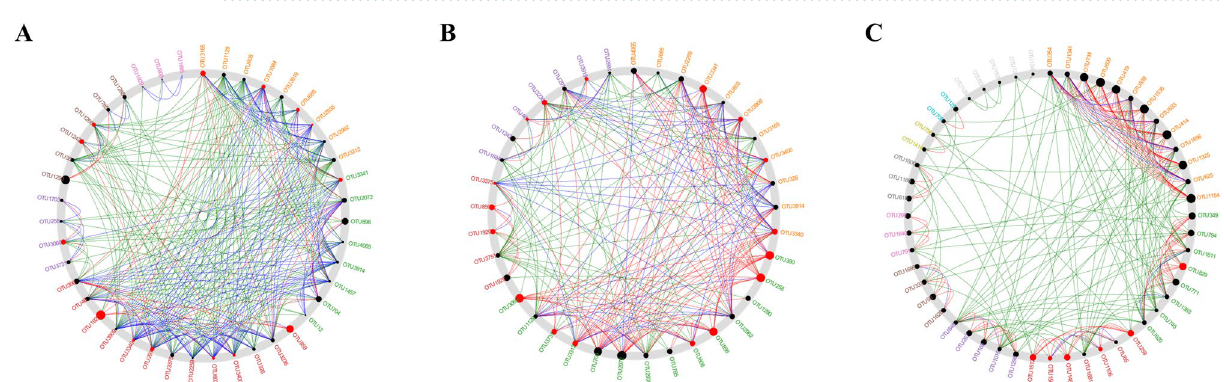
Figure 8. Analysis of potential taxa based on the network analysis of fungi and bacteria in inoculated and uninoculated wheat. ( A ) Potential taxa based on bacterial network analysis of inoculated and uninoculated resistant wheat. ( B ) Potential taxa based on bacterial network analysis of inoculated and uninoculated susceptible wheat. ( C ) Potential taxa based on fungal network analysis of inoculated and uninoculated resistant wheat. Red and large nodes are important "drivers", and grey out nodes represent nodes that exist simultaneously in the inoculated and uninoculated resistant wheat microbial community but directly interact with the common subnetwork. Red edges indicate associations present only in uninoculated wheat microbiomes, green edges indicate associations present only in inoculated wheat microbiomes, and blue edges indicate associations present in both inoculated and uninoculated wheat microbiomes. The NetShift method (https ://web.rniap ps.net/netsh ift) was used to identify the key taxa between healthy wheat and inoculated wheat microbial communities 27,28